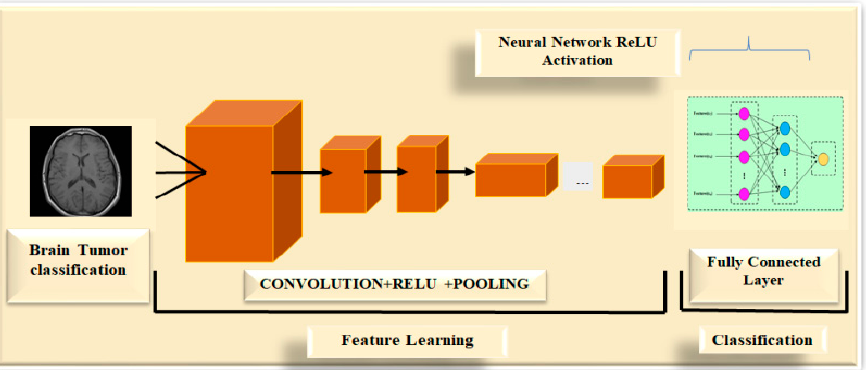
Figure 2. Representation of the CNN architecture.